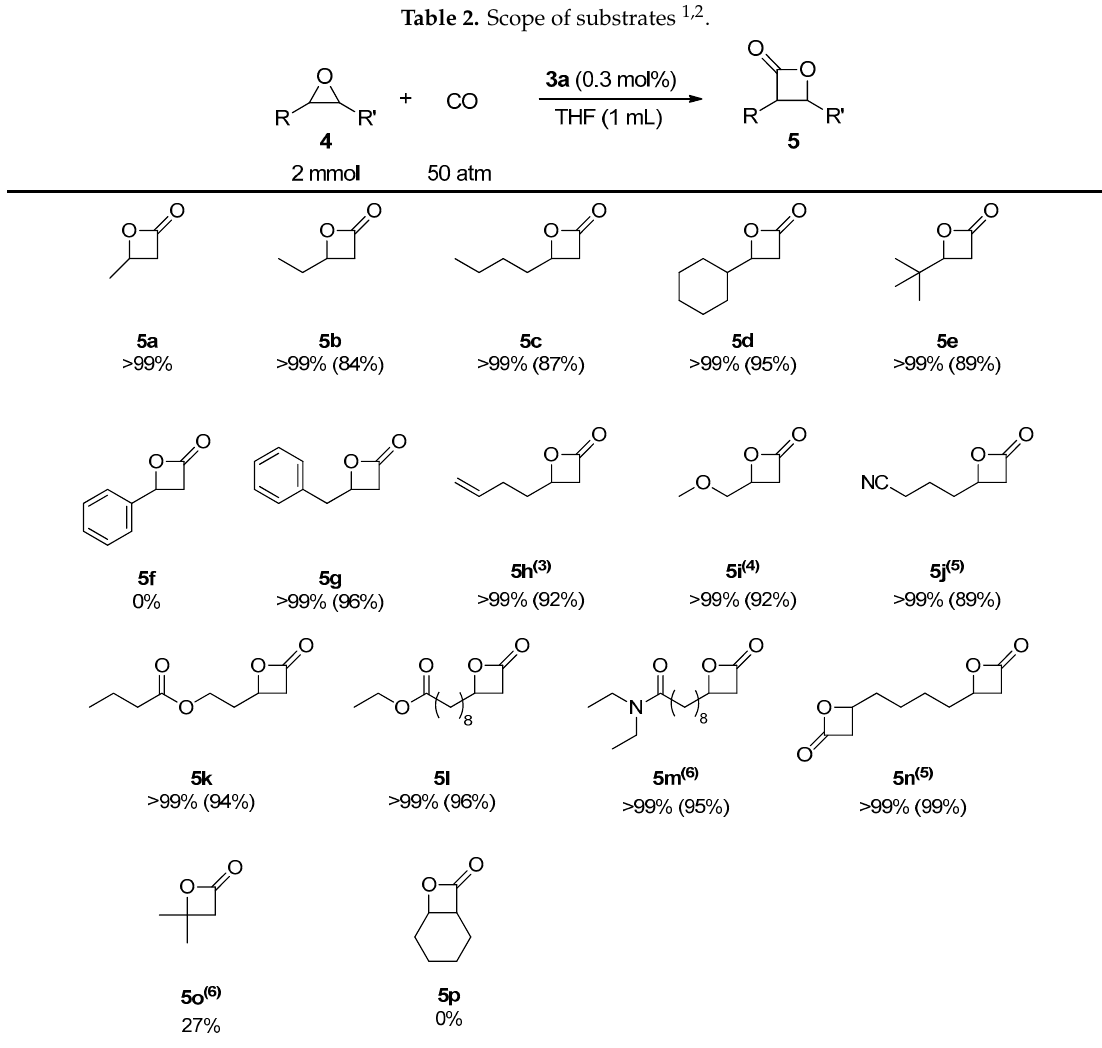
Table 2. Scope of substrates 1,2 .